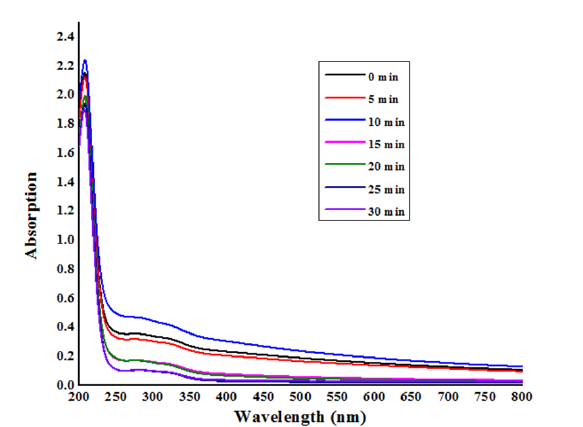
Figure 2: Observation of ZnO NPs formation by UV-Vis